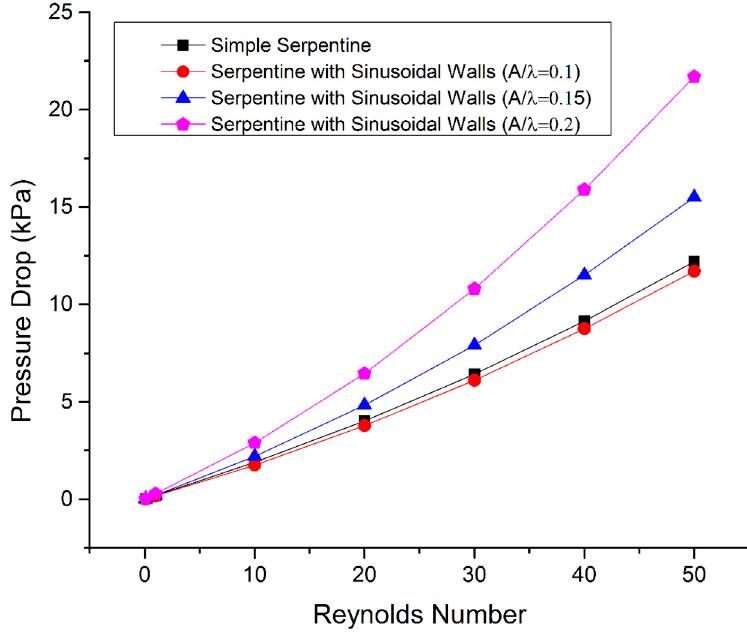
Figure 9. Pressure drop variation with the Reynolds number.